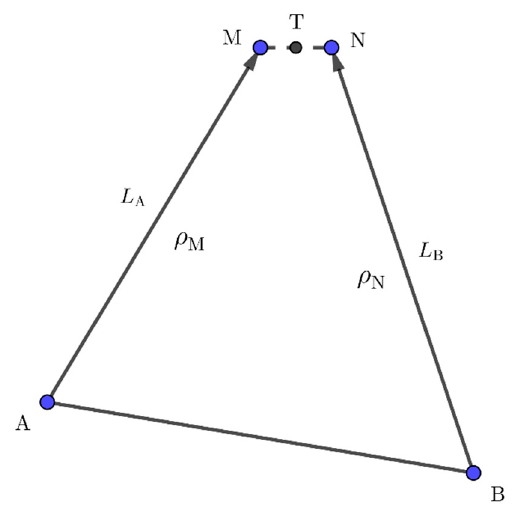
Figure 1. Two-site observation.